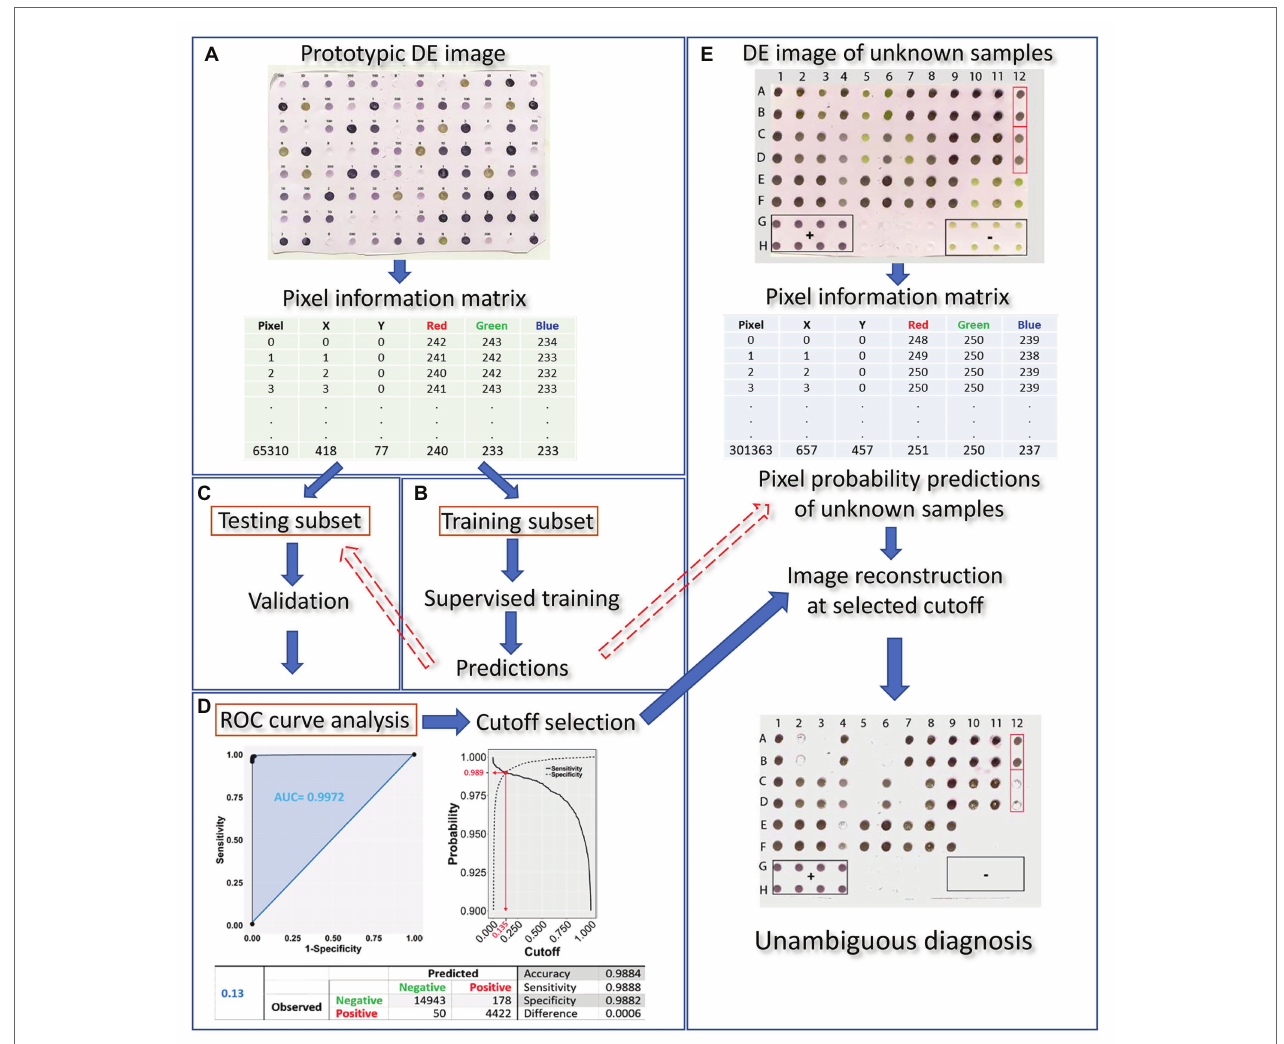
FIGURE 1 | Overview of the proposed machine learning approach for DE output evaluation that harnesses pixel information for dot classification and diagnosis in merely a few hundreds of seconds after running the blot using standard methods. The DE output is first scanned (at a resolution of 150 dpi) and the prototypic image is converted to a matrix, holding pixel position and color information for all pixels contained in the dots (A) . The matrix is then randomly tessellated into a training and testing dataset at a 70:30 ratio. Next, training of the classifier algorithm (B) is supervised by a logistic model of choice which, following validation (C) , is used for infection status predictions on the testing subset. Receiver operating characteristic (ROC) curve analysis allows for selection of an appropriate cutoff (D) . The procedure of scanning the blot and harnessing its pixel information is repeated on a DE of unknown samples (E) . Pixel probabilities of the unknown samples are predicted by the trained classifier and a new image of the blot, with dots consisting of pixels with probabilities above the selected cutoff, is reconstituted, allowing for proper dot classification and, hence, unambiguous